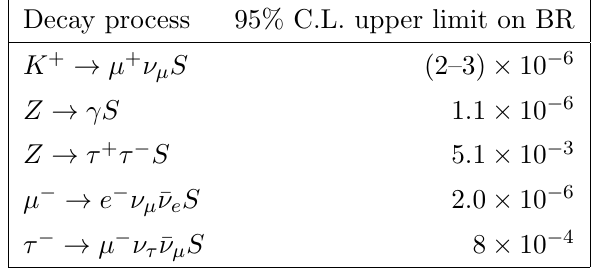
Table 1. Summary of rare decays that can probe g (cid:22) in the muon-speci(cid:12)c scenario. The 95% C.L. upper limits on the branching ratios are estimated based on [67] for K decays and data in [1] for Z , (cid:22) , and (cid:28) decays. Here S is assumed to decay